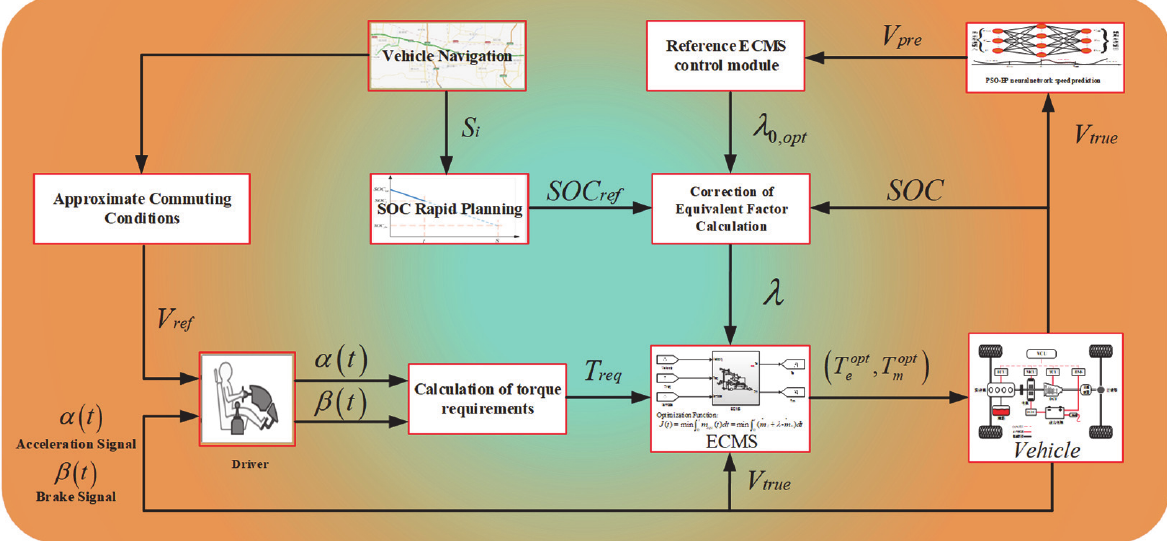
Figure 15. Flowchart of A − ECMS energy management strategy based on driving cycle prediction.